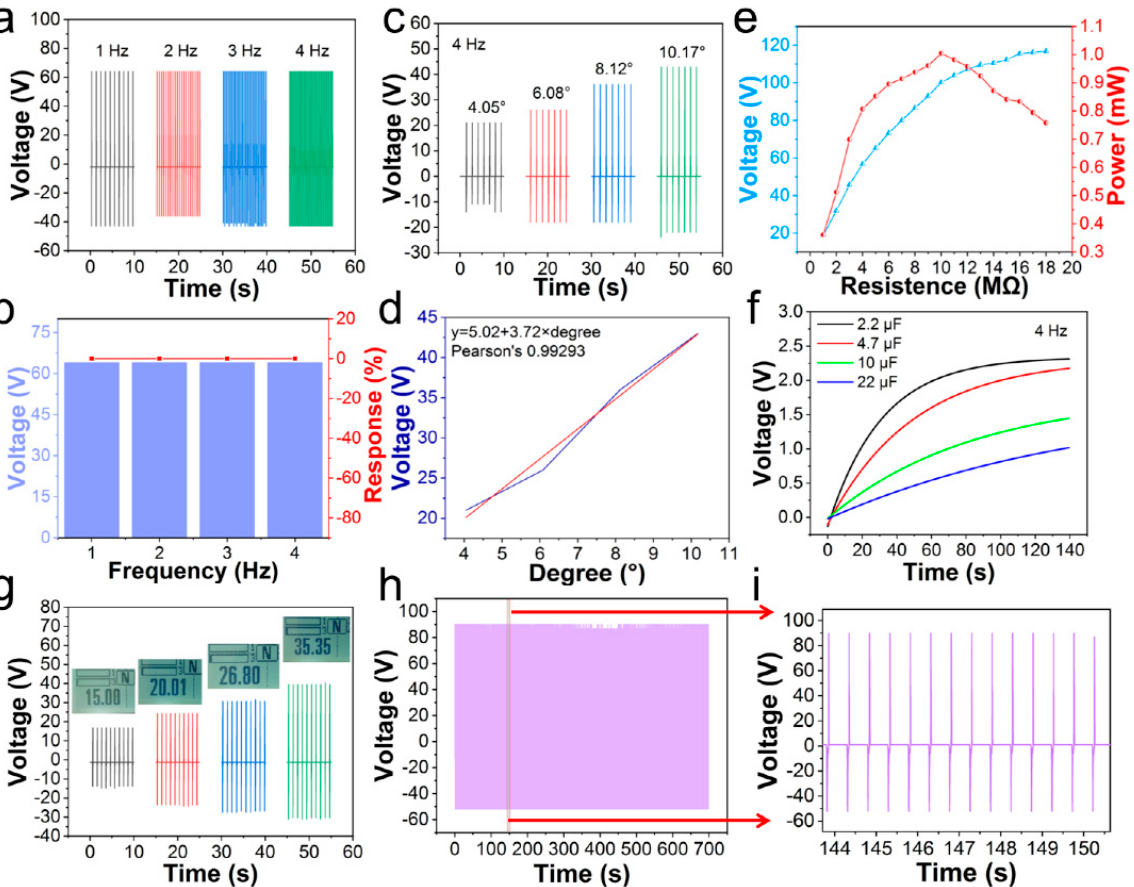
Figure 3. The electrical output performance of SD-TENG. ( a ) Relationship between the frequency and output voltage of SD-TENG for the same bending angle. ( b ) The voltage responses of SD-TENG at different frequencies. ( c ) Relationship between the angle and output voltage of SD-TENG at the same frequency. ( d ) Linear fit between the output voltage and bending angle of SD-TENG at the same frequency. ( e ) The voltage and power of SD-TENG under different load re- sistances. ( f ) The SD-TENG charging the 2.2 μ F, 4.7 μ F, 10 μ F and 22 μ F capacitors. ( g ) The test of